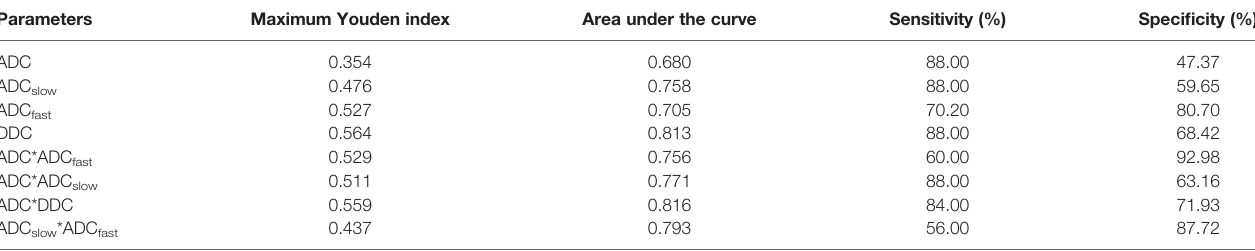
TABLE 3 | ROC-related parameters in differentiating the poorly and well-/moderately differentiated group of ESC. Parameters